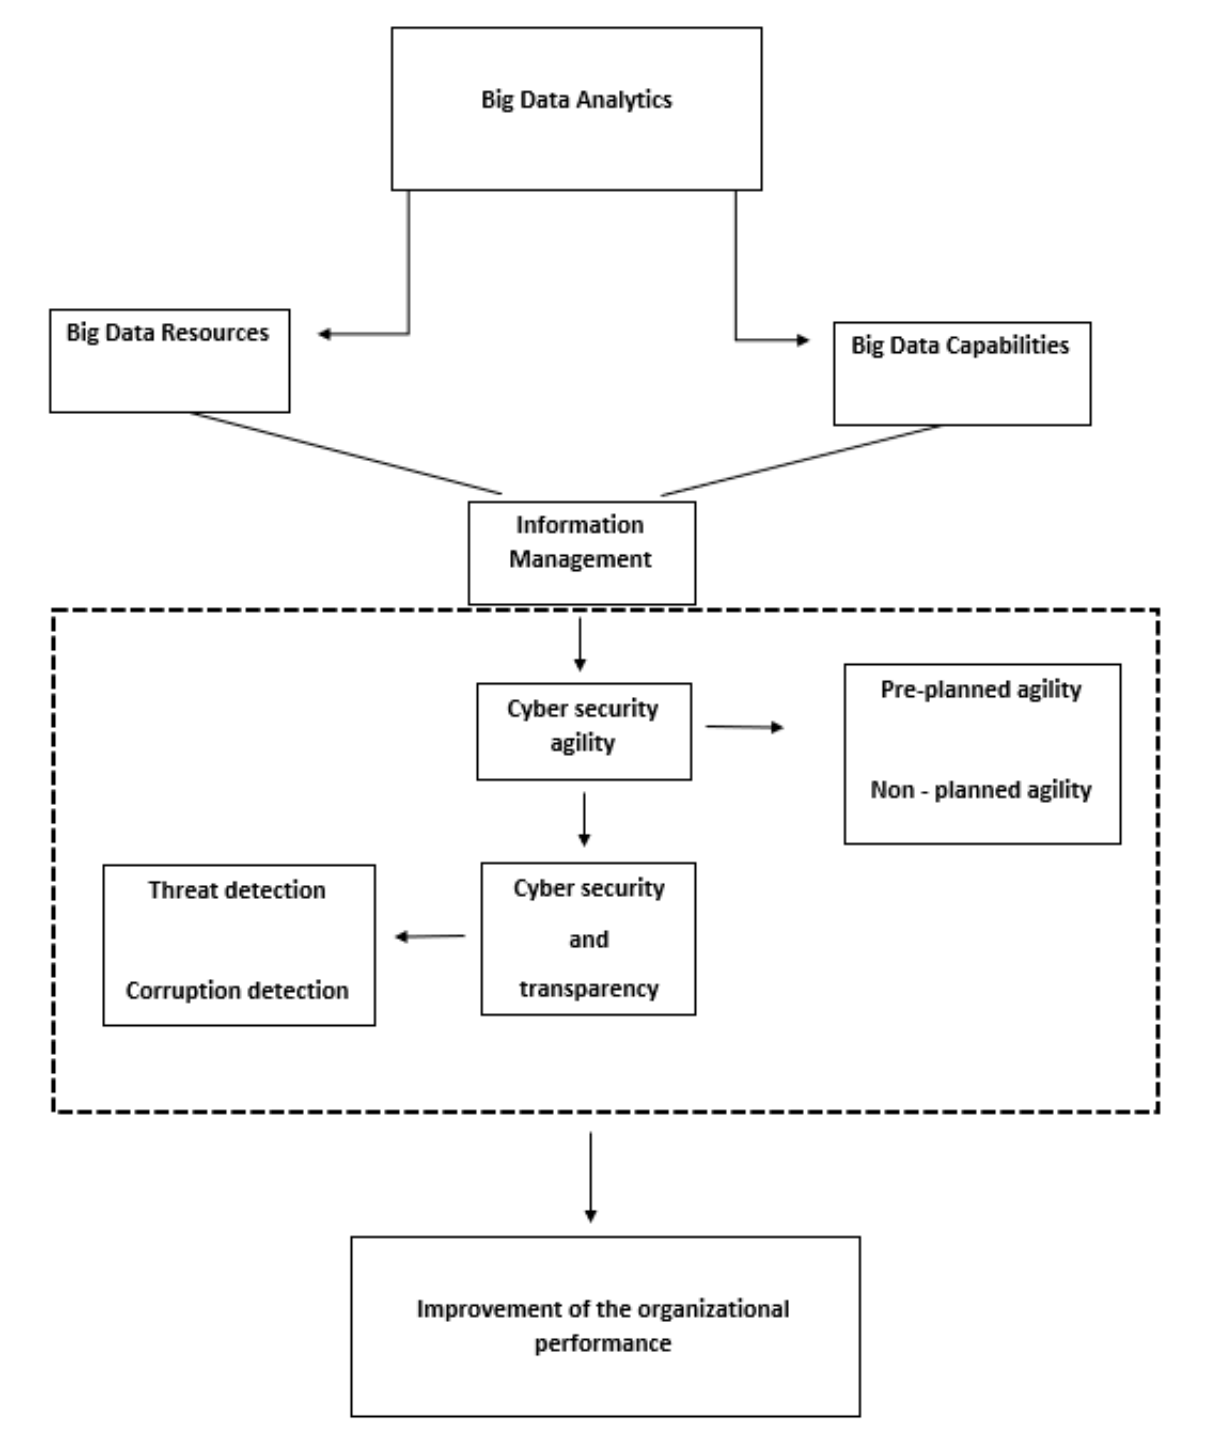
Figure 14. Proposed business model.